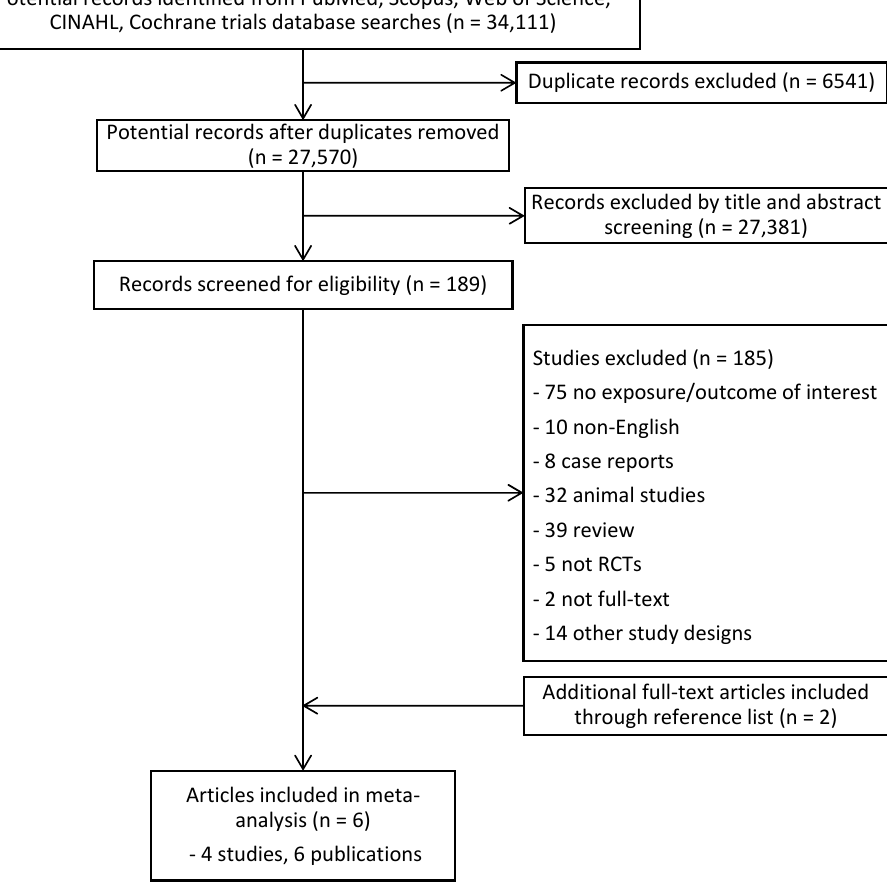
Figure 1. Flow diagram of the literature search process.